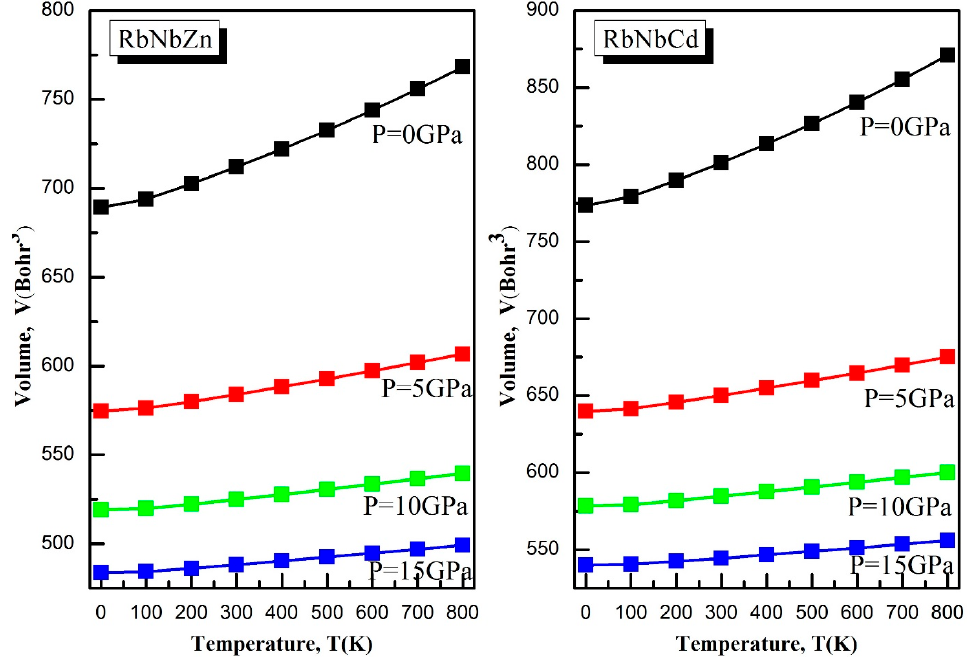
Figure 7. The Volume (V) as a function of temperature at different pressures for RbNbCd and RbNbZn.